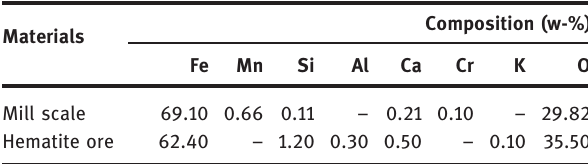
Table 3: XRF analysis of mill scale and ore material used in the experimental